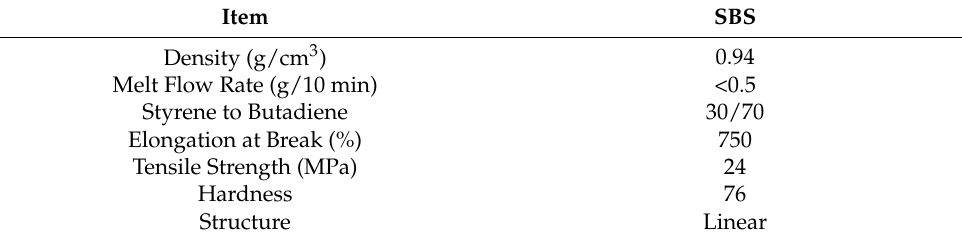
Table 2. Basic properties of SBS.